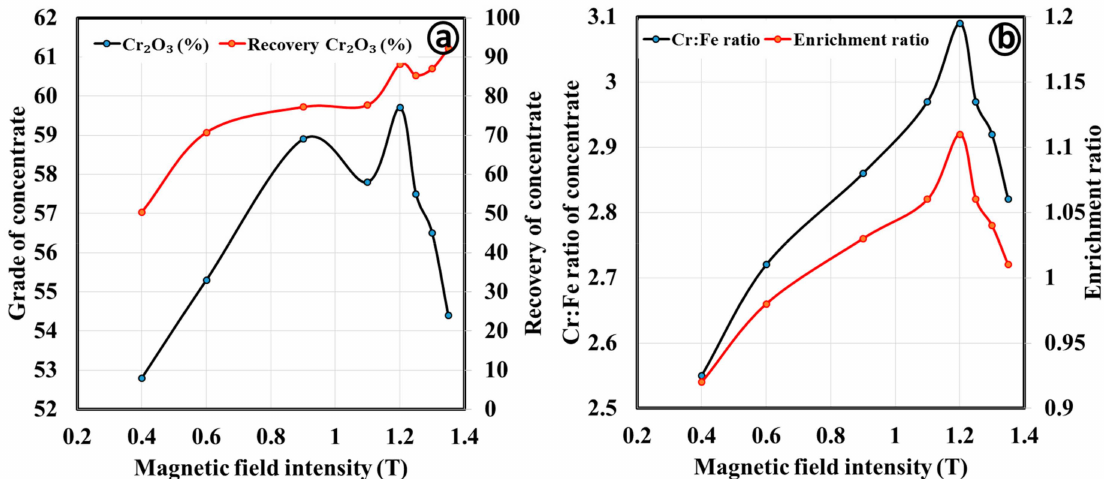
Figure 13. Influence of the magnetic field intensity on the treating fine concentrate by the WHIMS ( a ) for grade and recovery; ( b ) for Cr:Fe ratio and enrichment ratio of